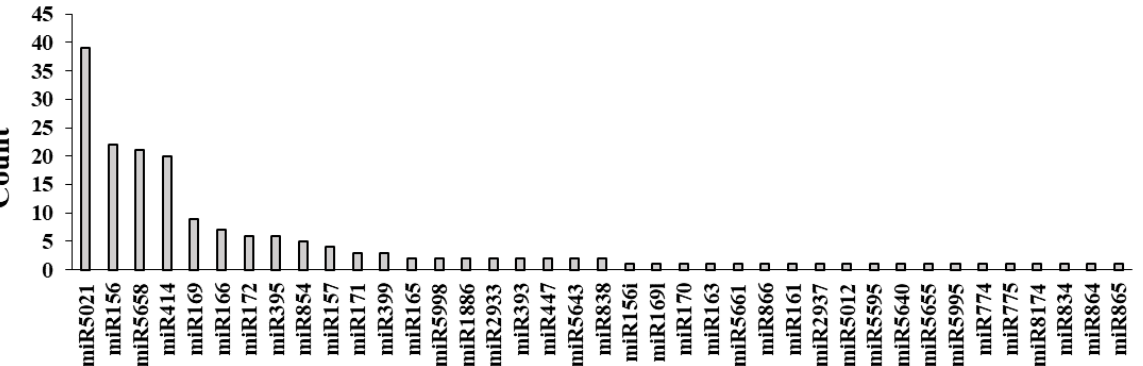
Figure 5. miRNAs associated with the DEGs and discovered by use of the computational algorithm psRNATarget server. The filtering was performed based on a highly stringent penalty score (≤2).